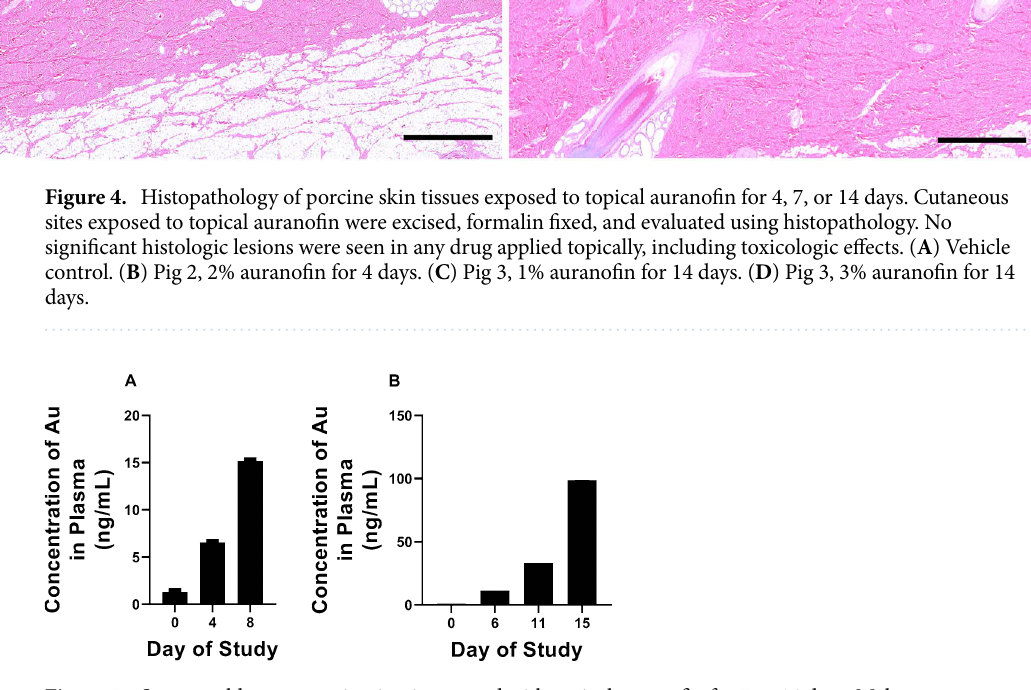
Figure 5. Serum gold concentration in pigs treated with topical auranofin for 7 or 14 days. Male castrate Landrace cross pigs were treated with topical auranofin for ( A ) 7 days (pig 2, 2% auranofin b.i.d.) or ( B ) 14 days (pig 3, 1% or 3% auranofin b.i.d.). Blood samples were obtained in metal-free tubes before exposing pigs to auranofin (day 0) and on days 4 or 8 (for pig 2) or on days 6, 11, and 15 (for pig 3) of the study. Samples were centrifuged and plasma was analyzed for total gold concentration (corresponding to auranofin) via